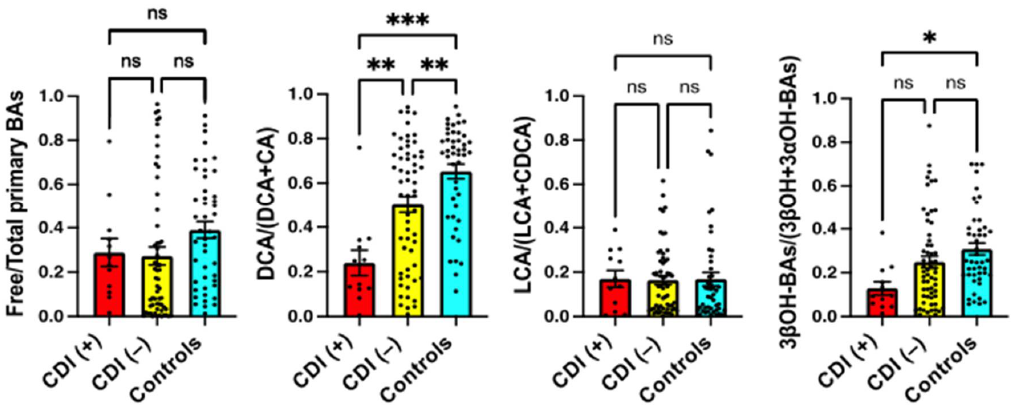
Figure 2. Serum BA markers in patients who were admitted to the Gastroenterology and Hepatology division due to high inflammatory responses in blood tests. Serum samples were obtained on admission (prior to antibiotic use and CDI onset). CDI (+), patients who developed CDI during hospitalization ( n = 12); CDI ( − ), patients who did not develop CDI ( n = 59); Controls, healthy controls ( n = 46). Each column and error bar represents the mean and SEM. According to the Tukey–Kramer test, * p < 0.05, ** p < 0.01, and *** p < 0.0001 were significantly different. ns, not significant.